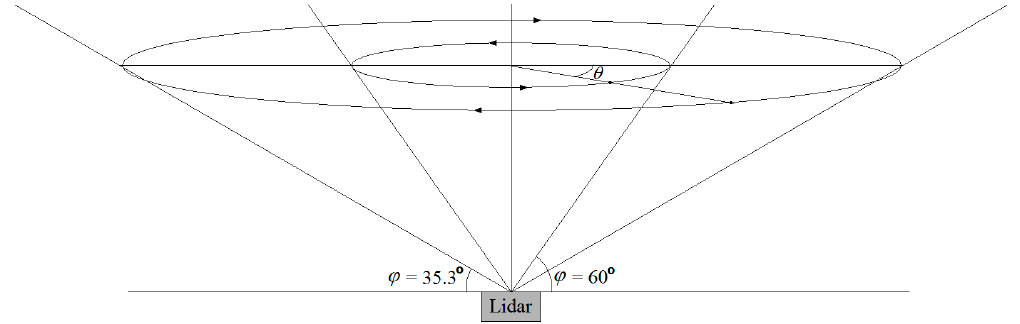
Figure 1. Geometry of lidar measurement employing alternate conical scanning around the vertical axis at the elevation angles ( ϕ ) of 35.3° and 60°.